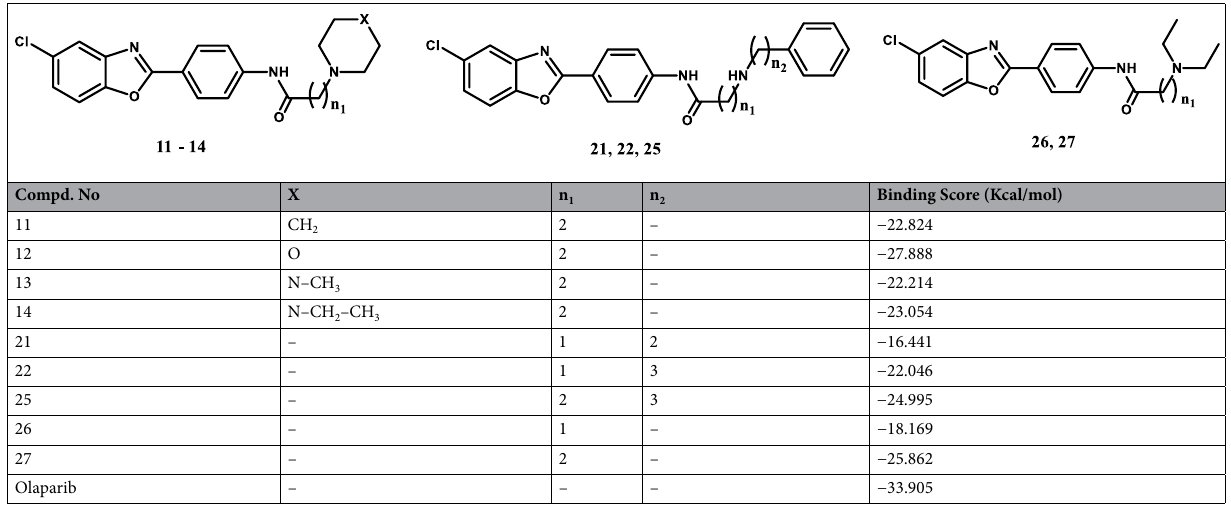
Table 3. Binding scores of compounds 11–14, 21, 22, 25–27 and olaparib docked with PARP-2 enzyme.